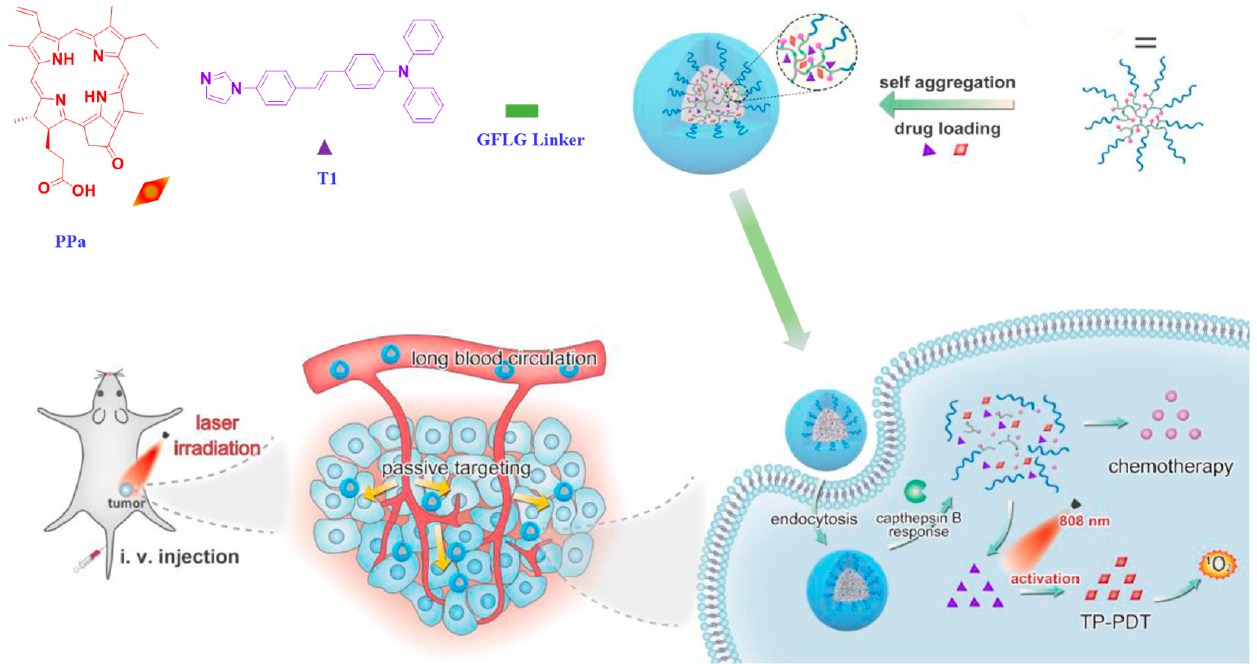
Figure 7. Preparation of cathepsin B-responsive dendritic prodrug and dendritic-[(GFLG-polyPTX)- block-polyOEGMA]. The self-assembled dendritic prodrug is loaded with TPA and PPa, leading to synergistic effect of chemotherapy and two-photon photodynamic therapy for breast tumor. Adapted with permission from ref. [66] Copyright 2021 Elsevier Ltd.